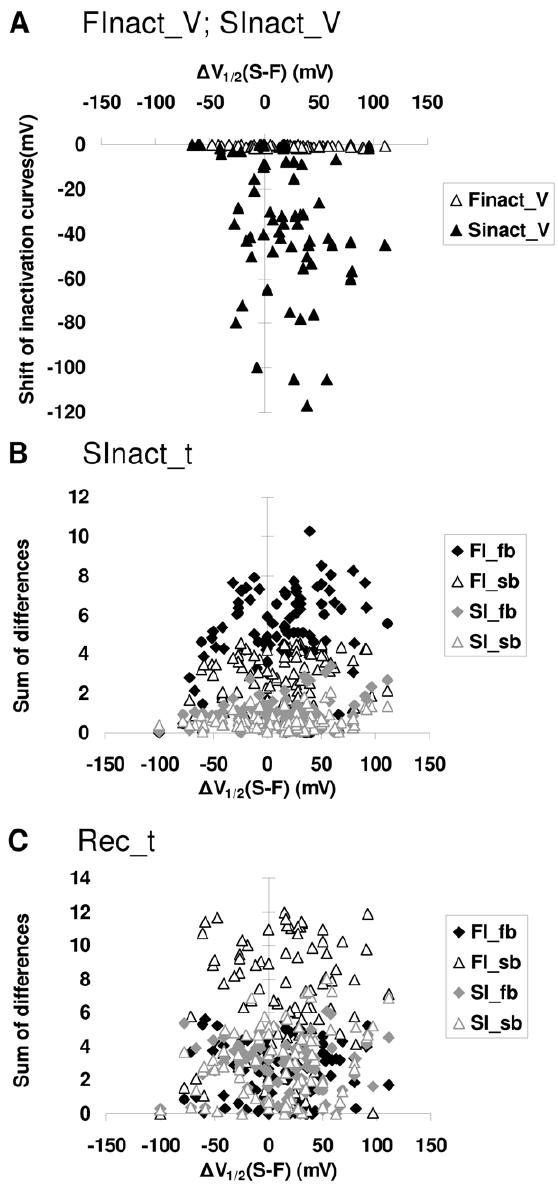
Figure 4. Results of 100 simulations with random parameters of the tetracube model. Measures of the potency of the four prototypical ‘‘drugs’’ are plotted against the difference between V 1/2 values for fast and slow inactivation. A , Leftward shift of the V 1/2 of ‘‘FInact_V’’ and ‘‘SInact_V’’ curves, caused by ‘‘FI_sb.’’ B , Effect of all four ‘‘drugs’’ on the ‘‘SInact_t’’ curve. The effect was quantified by calculating the sum of differences between control and drug curves (see Figure 3C). C , Effect of all four ‘‘drugs’’ on the ‘‘Rec_t’’ curve. Sum of differences between the curves in control conditions, and during drug application. (see Figure